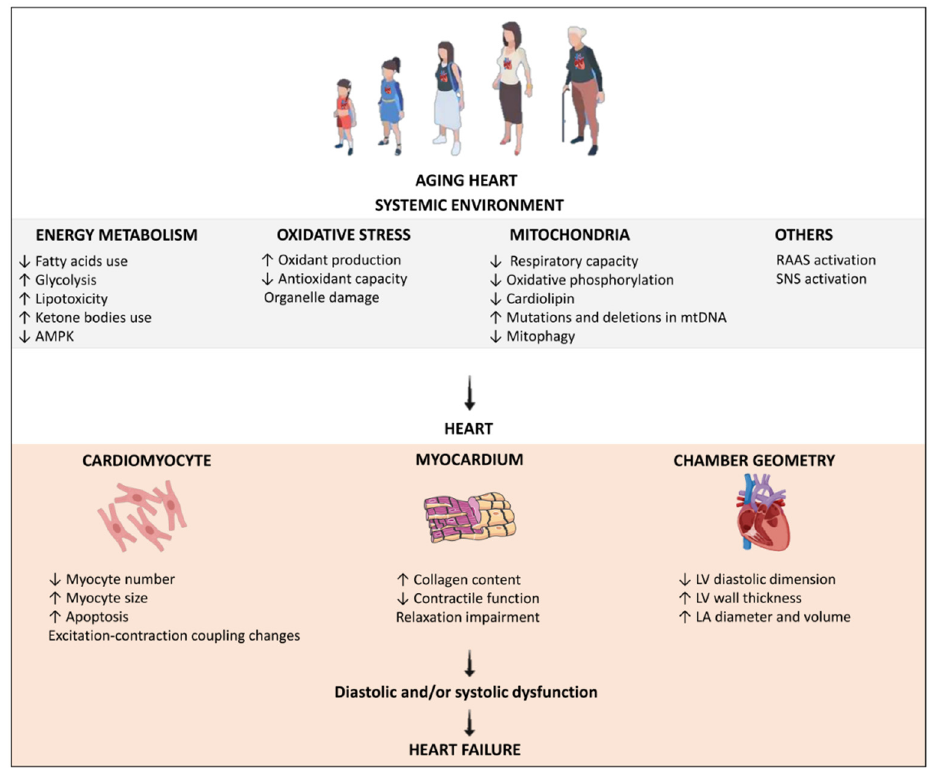
Figure 2. The mechanisms involved in heart structure and function impairment during cardiac aging. AMPK: adenosine monophosphate activated protein kinase; RAAS: renin-angiotensin-aldosterone system; SNS: sympathetic nervous system; LV: left ventricle; LA: left atrium.